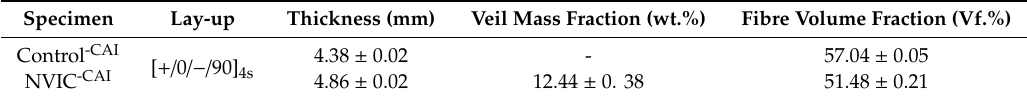
Table 5. Characteristics of specimens for CAI study.